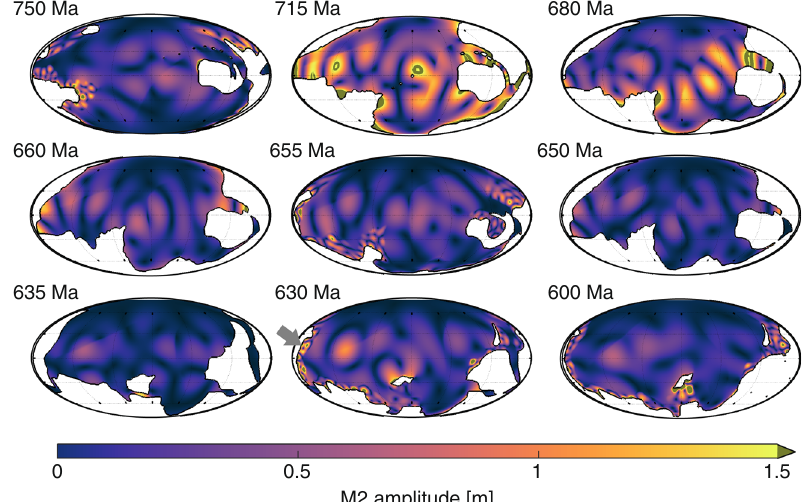
Fig. 1 Simulated M2 tidal amplitudes in metres for the time slices representing 750, 715, 680, 660, 655, 650, 635, 630 and 600 Ma (see labels in the top left hand corner of each panel; note that all global maps are plotted on a Mollweide projection). Note that the colour scale saturates at 1.5 m, in a grey-green colour, for clarity. The grey arrow at 630 Ma point to the coastline where the Elatina formation 31 is now located. The formation gives a tidal proxy showing a range consistent with the one presented from the